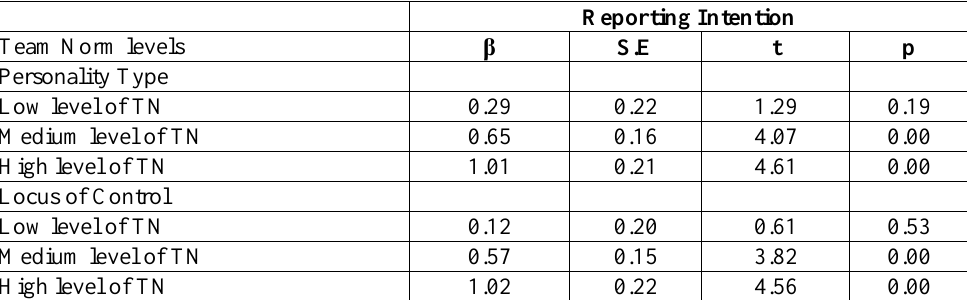
Table 6. The Effects of Personality Type and Locus of Control on Auditor intention for Reporting Misstatements at Low, Medium and High Levels of Team Norms (Simple Slopes Analysis) Reporting Intention Team Norm levels β S.E